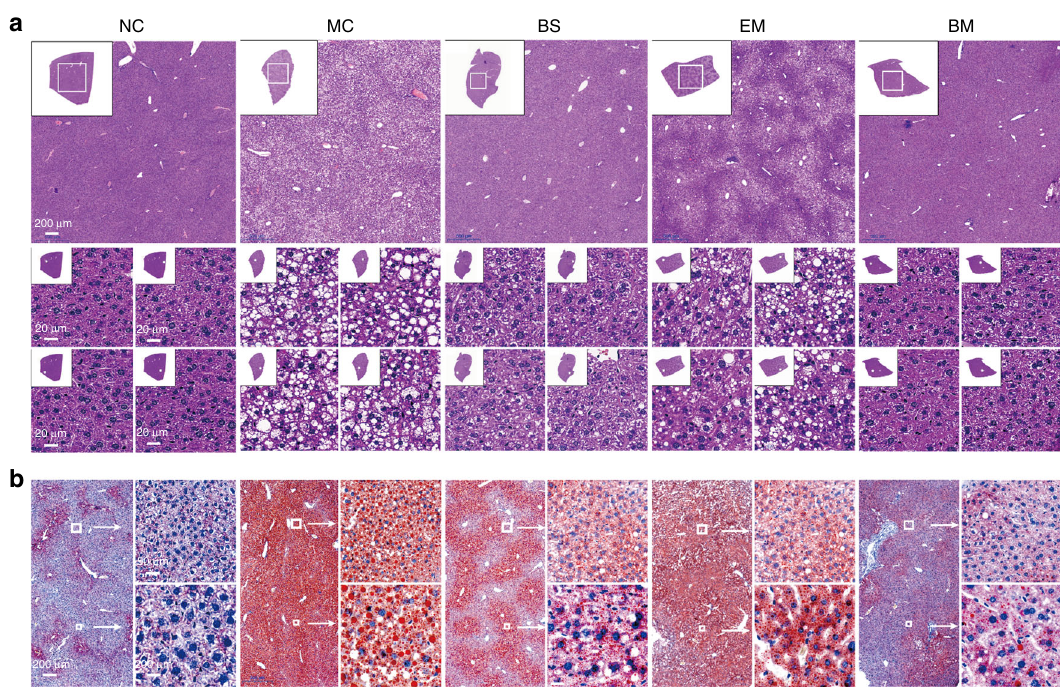
Fig. 7 Fatty liver and hepatic injury evaluation. HFD-fed C57BL/6J mice were treated with various BBR formulations by gavage ( n = 10 for each group). Untreated mice fed with HFD or standard chow food (NC group) were used as control. a Representative photographs of HE-stained liver sections. Insets contain images of whole liver tissue section. The regions of interest (ROI) are boxed in white, and their magni fi ed images are shown at the right. b Representative photographs of oil Red O stained liver sections. The regions of interest (ROI) are boxed in white, and their magni fi ed images are shown at the